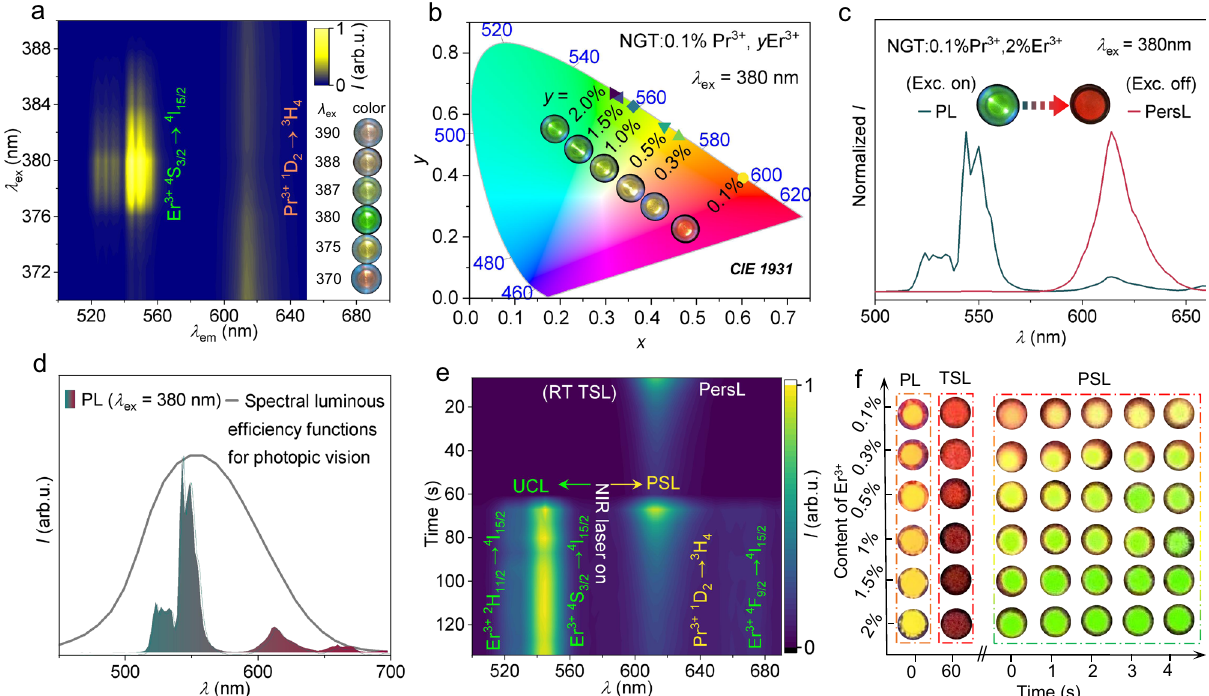
Fig. 2 | Manipulating emission color in space and time dimensions. a Contour plot of the excitation-dependent PL of the NGT:0.1%Pr 3+ , 1.5%Er 3+ . The right sides show photographs of the sample under selected excitations. b CIE chromaticity coordinates and corresponding photographs of NGT:0.1%Pr 3+ , y Er 3+ ( y =0.1 – 2%) when fi xing the excitation wavelength at 380nm. c Comparison of normalized PL and PersL spectra and the corresponding photographs of NGT:0.1%Pr 3+ , 2%Er 3+ under/after380nmexcitation. d Spectralsensitivityfunctionoftheaveragehuman eyeunderphotopicvision 27 comparedwiththeemissionspectrumofNGT:0.1%Pr 3+ , 1.5%Er 3+ excited by 380nm. Exc., excitation. e The PersL (thermo- stimulated luminescence (TSL) at RT), PSL and up-converted photoluminescence (UCL)